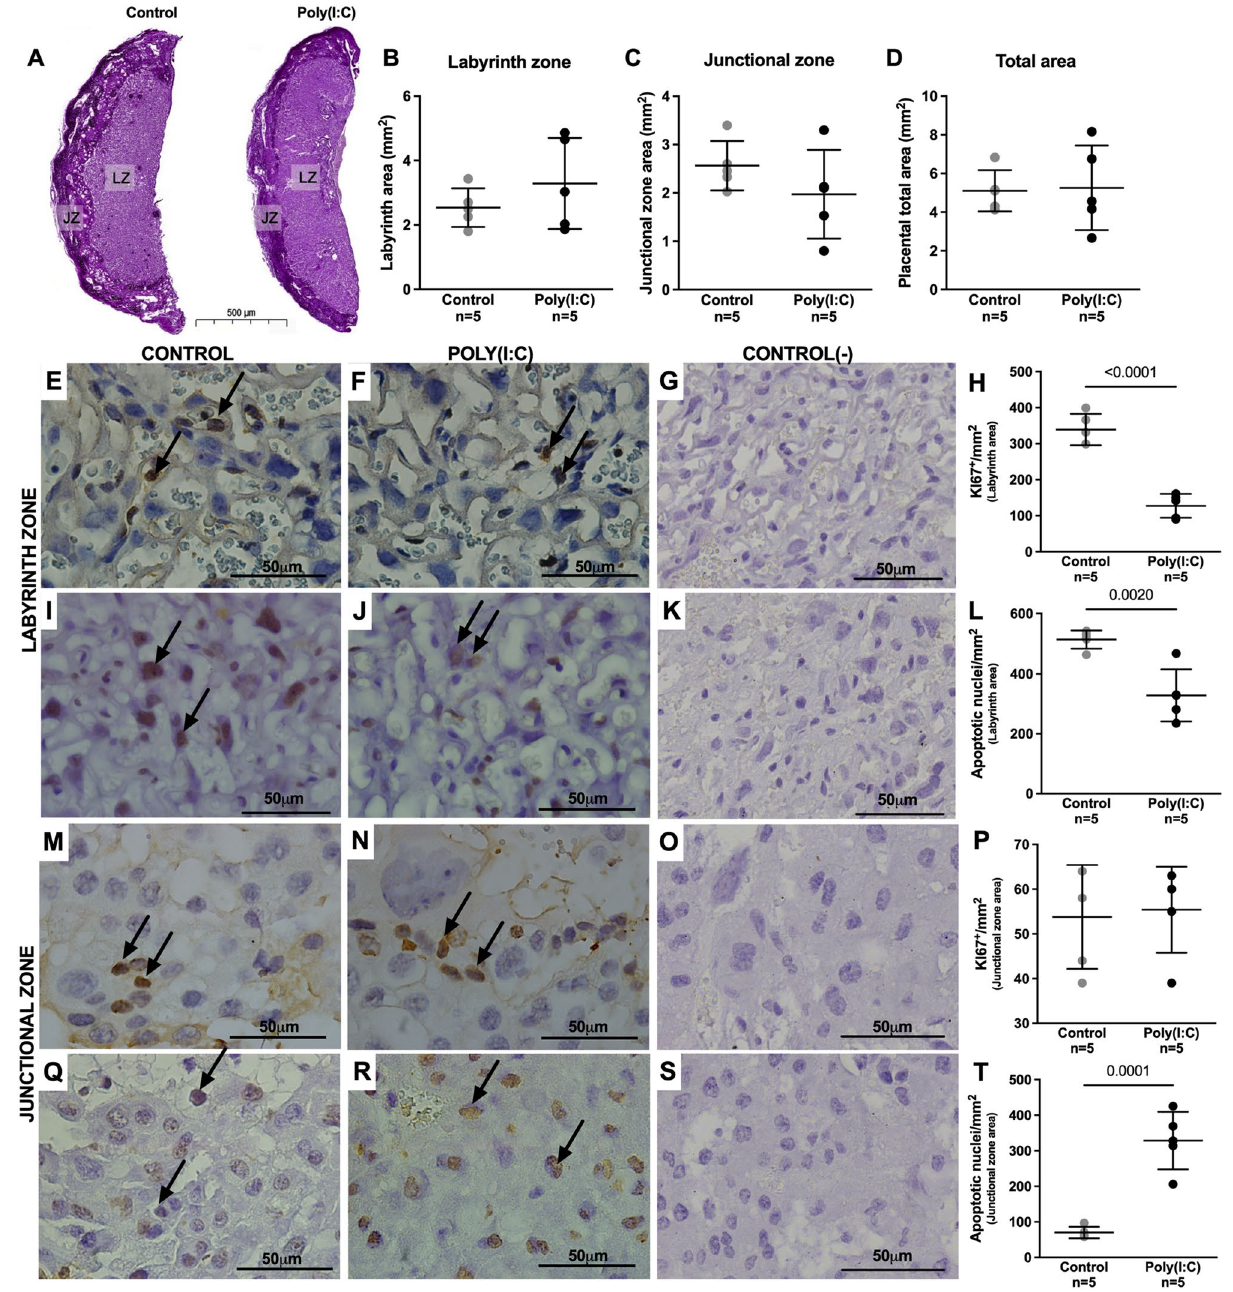
Figure 2. Placental remodeling after mid-pregnancy poly(I:C) exposure. ( A ) Representative images of PAS- stained at GD18.5 showing the delimitation of placental areas. ( B – D ) Quantification of the areas of the Lz ( B ), Jz ( C ) and total placental area ( D ). Representative images from Ki67 + nuclei and its quantification in Lz ( E – H ) and Jz ( M – P ). Representative images from apoptotic nuclei and its quantification in Lz ( I – L ) and Jz ( Q – T ). The graphs were plotted in aligned dot plot, the gray circles represent the control group, and the black circles represent the poly(I:C) group. The Lz’s ( G , K ) and Jz’s ( O , S ) negative controls were performed with the omission of the primary antibody. Values are expressed as mean ± SD. Student’s t test was